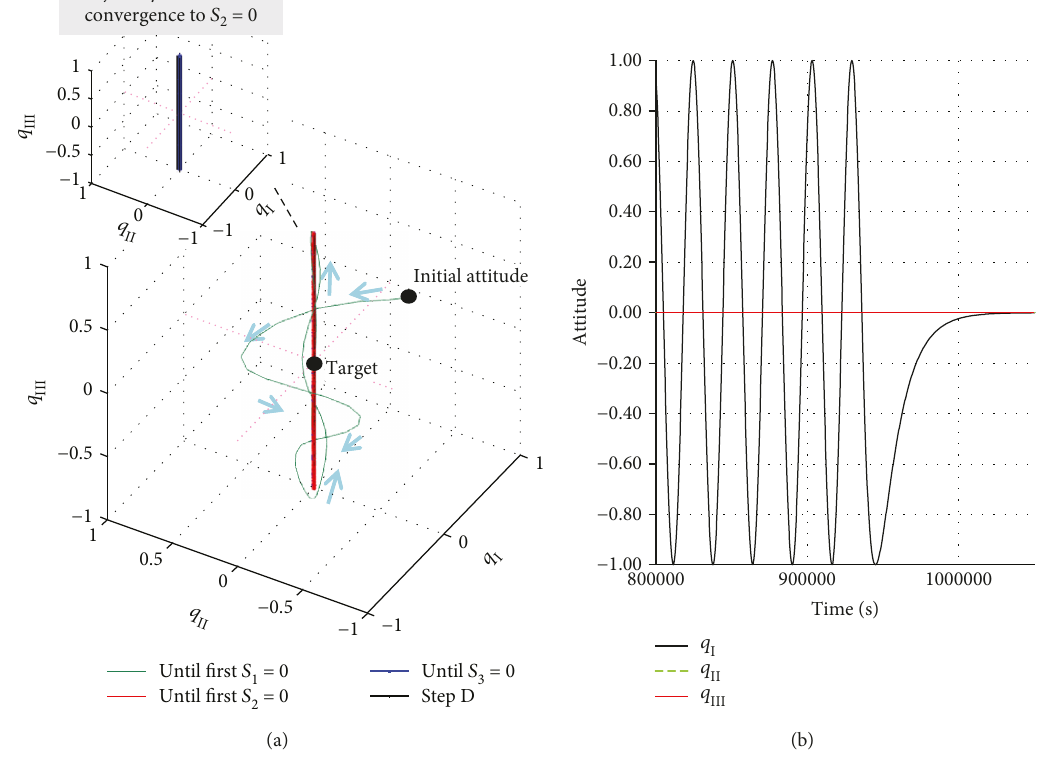
Figure 11: Attitude in case 2. (a) Attitude trajectory to the target. (b) Attitude history around the